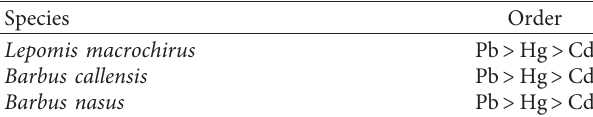
Table 8: Order of trace metals accumulated in the fish muscles.